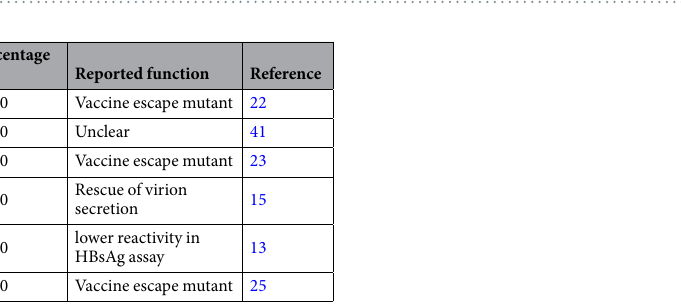
Table 3. Amino acid mutations in the “ α ” determinant of HBsAg from genotype C among HBV-infected children. a Amino acid aa mutants were presented based on their location in the archived GenBank reference AF473543. b Frequency reflected the number of cases in which the mutations was detected. c Unreported mutants were considered novel.